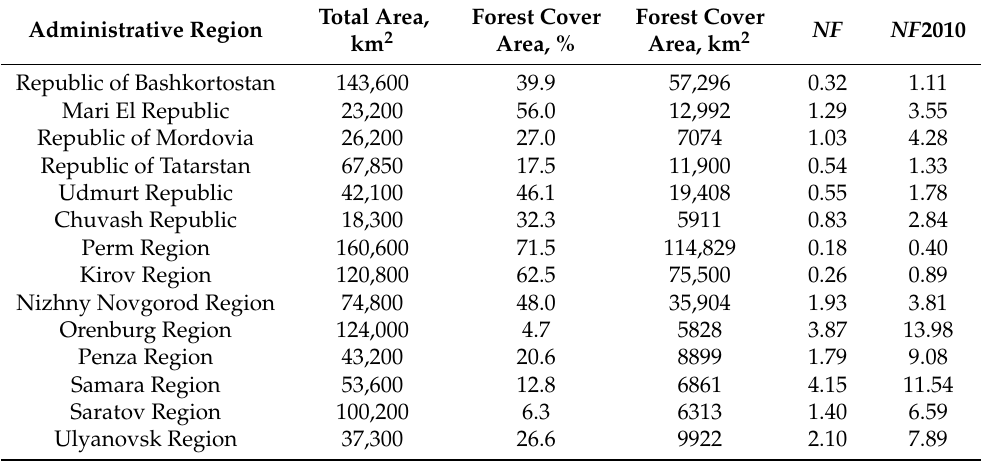
Table 2. Forest cover, NF , and NF 2010 within the administrative regions of the Volga Federal District (see Figure 1).